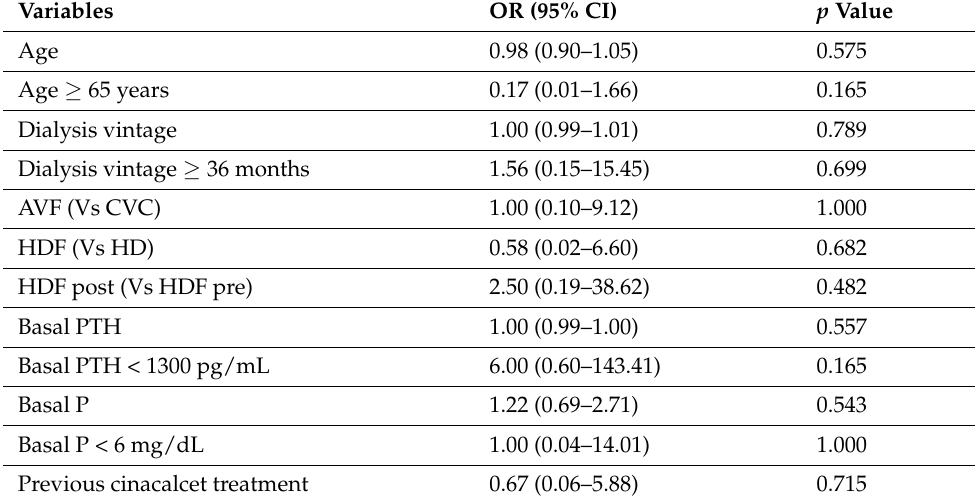
Table 4. Univariate logistic regression to achievement of PTH reduction endpoint ≥ 30% at 6 months. OR, odds ratio; CI, confidence interval.